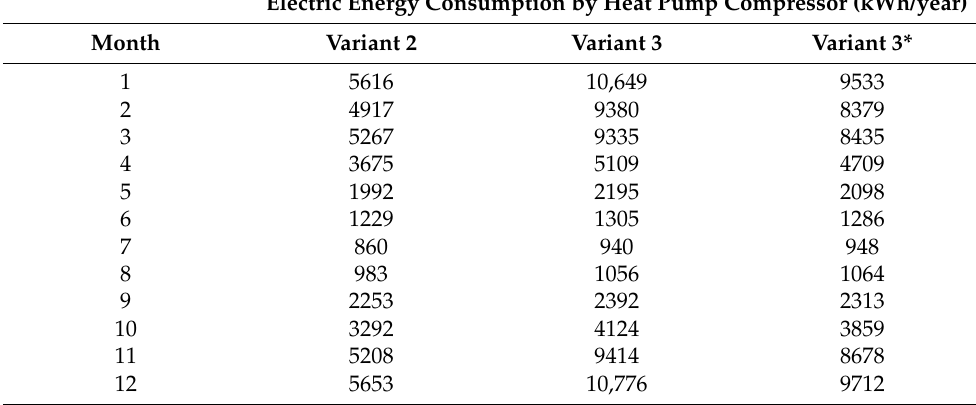
Table 2. Electric energy consumption by heat pump